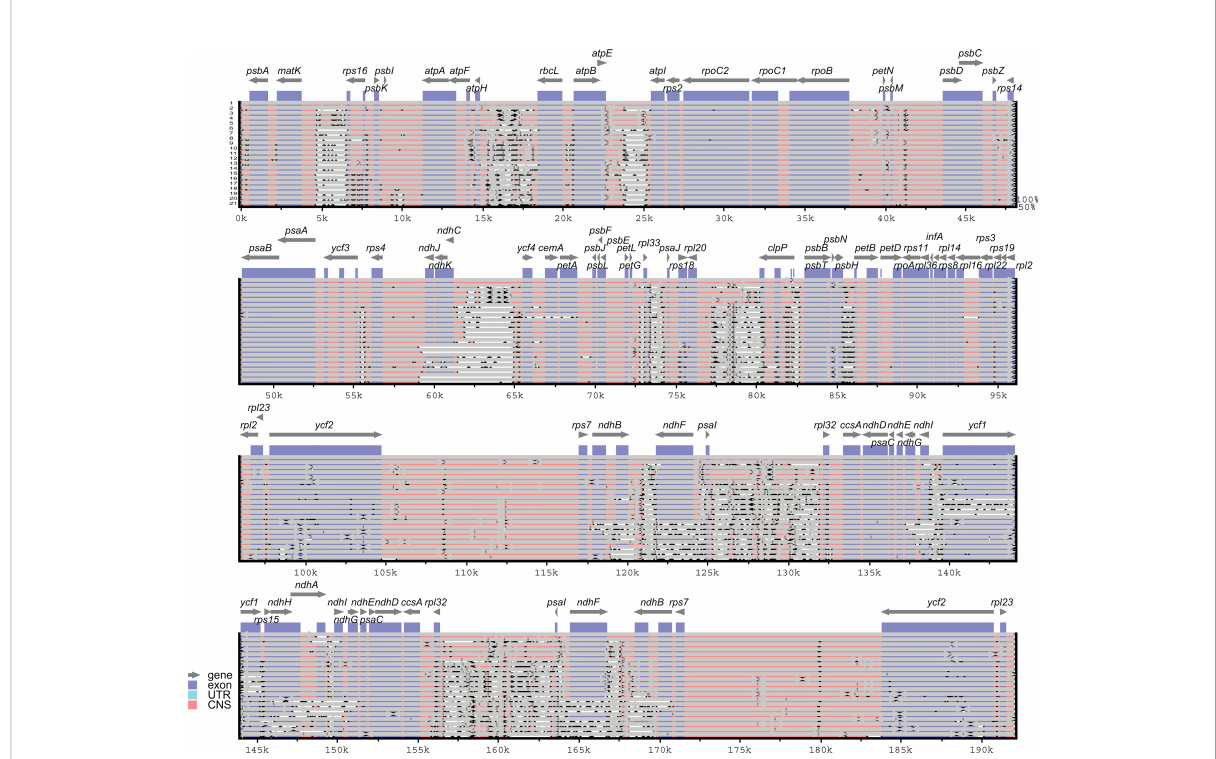
FIGURE 6 mVISTA-based sequence identity plot of 21 Corydalis plastomes with C. platycarpa as a reference. The gray arrows indicate the direction of the gene transcription. The y-axis represents the percent identity ranging from 50 to 100% is represented by the vertical scale. Coding and non- coding regions are colored purple and pink, respectively. 1. Corydalis platycarpa ; 2. Corydalis adunca ; 3. Corydalis saxicola ; 4. Corydalis tomentella ; 5. Corydalis fangshanensis ; 6. Corydalis hsiaowutaishanensis ; 7. Corydalis impatiens ; 8. Corydalis inopinata ; 9. Corydalis